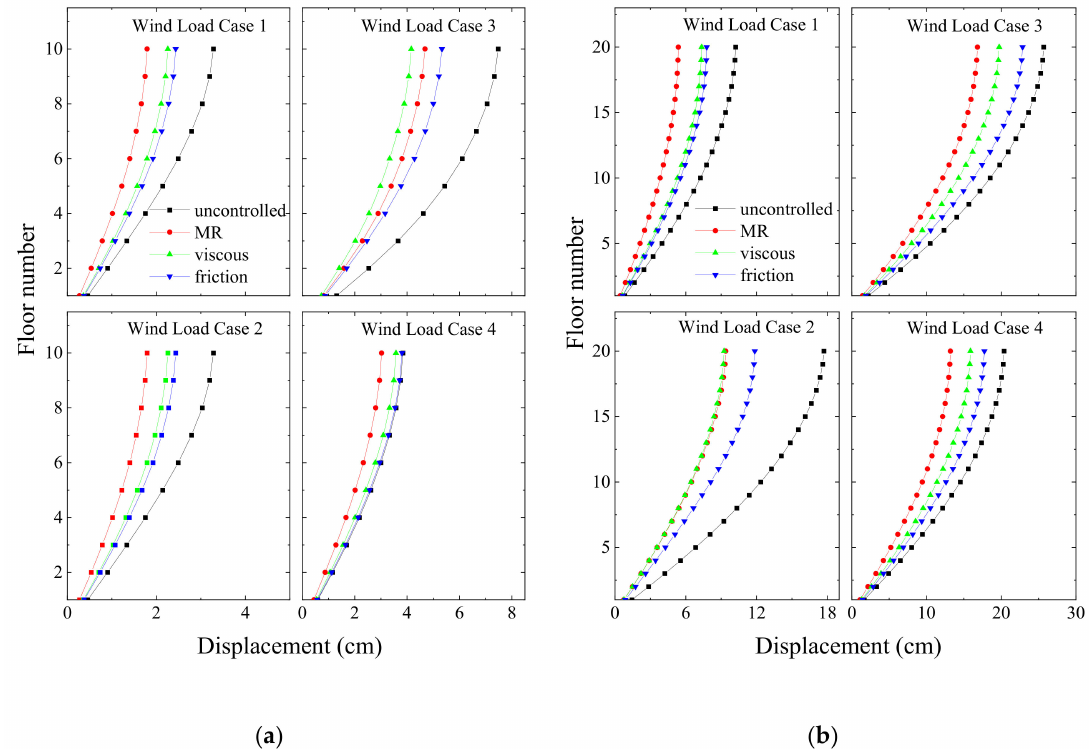
Figure 32. Peak floor displacement response under wind excitation obtained from different dampers in: ( a ) a coupled stiff building and ( b ) a coupled flexible building when dampers are arranged in Configuration